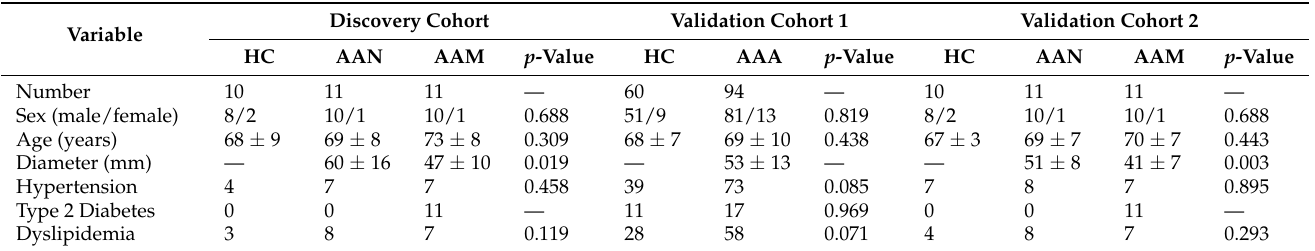
Table 1. Clinical characteristics of the subjects in this